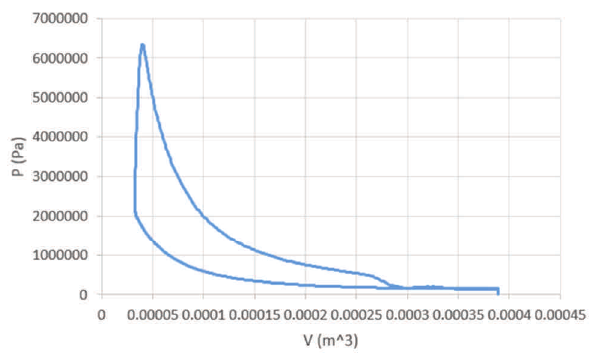
Fig. 4c. Graph of cylinder pressure against cylinder volume